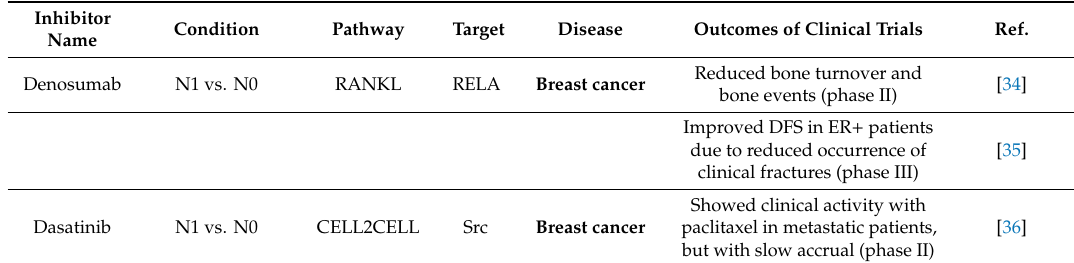
Table 3. Overview of clinical trials of selected